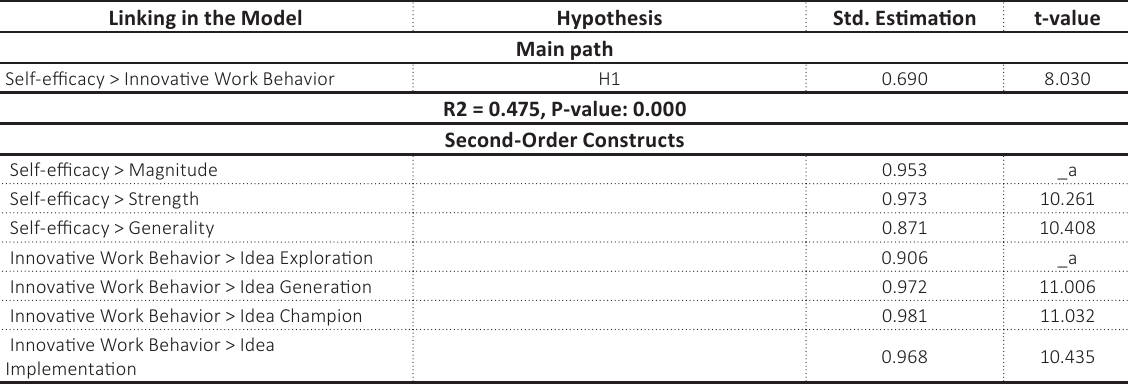
Table 4. Constructs of the structural